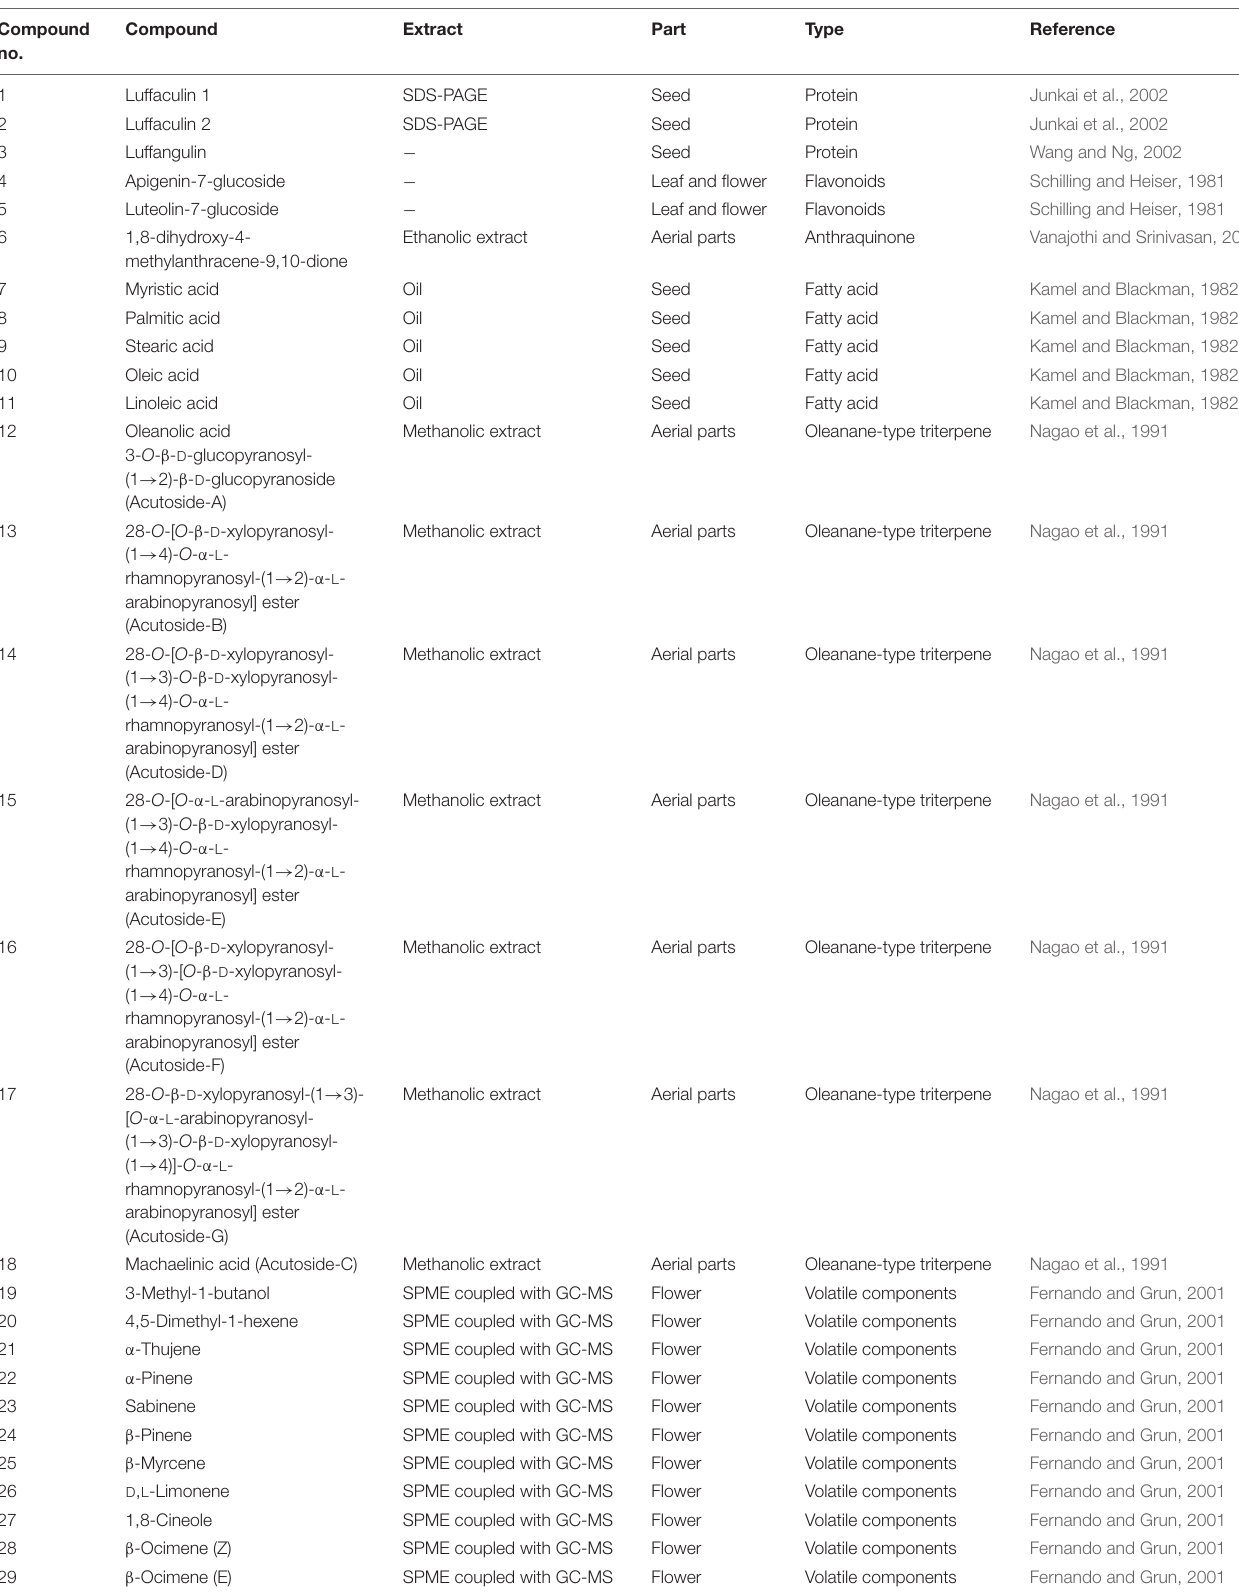
TABLE 1 | Isolated phytochemicals of Luffa acutangula. Compound